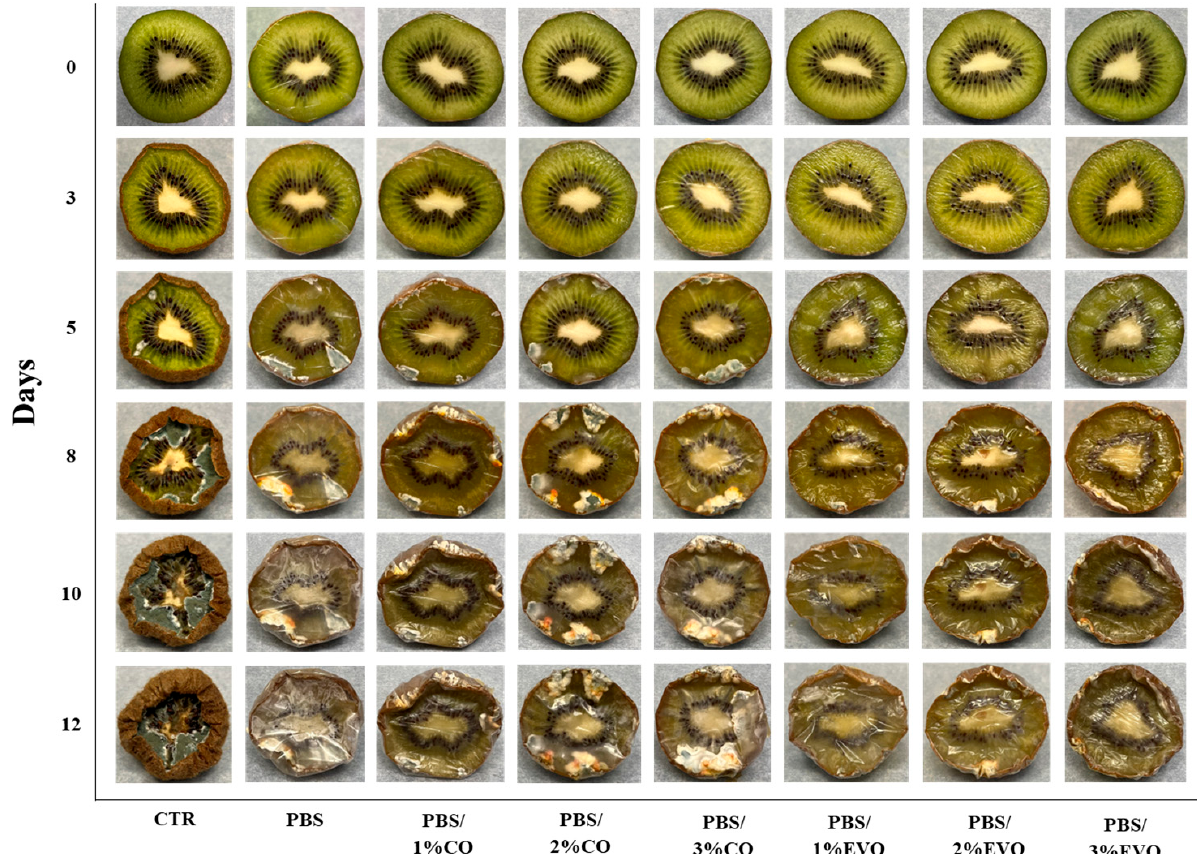
Figure 9. Appearance of fungal growth on sliced kiwi after 12 days of storage with and without PBS and PBS-based films/formulations stored at room temperature.